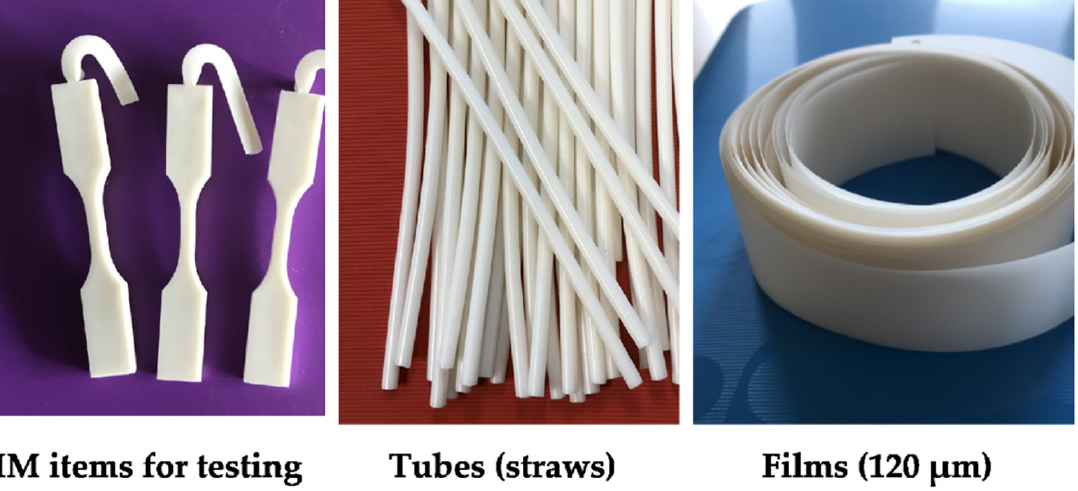
Figure 15. Examples of products obtained using the sample PLA/0.3J–AII–10TBC (TSE) and different techniques of processing (IM and extrusion (tubes and films)).